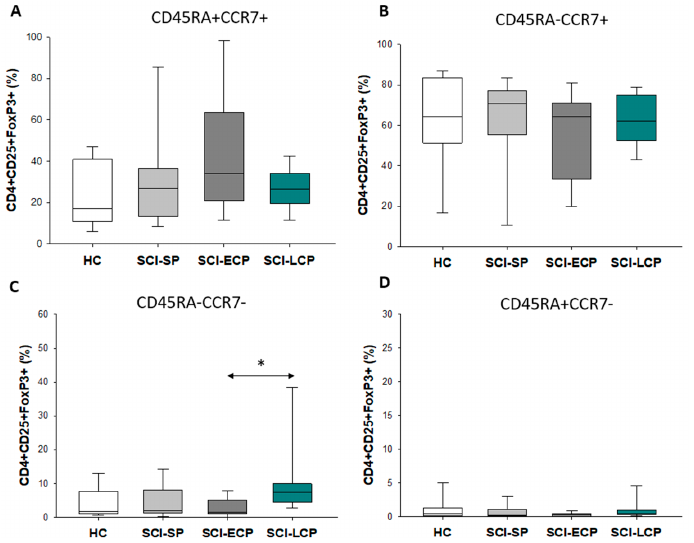
Figure 2. CD45RA and CCR7 expression in CD4+ CD25+ Foxp3+ Tregs. 4 subpopulations are recognized: ( A ) CD45RA+ CCR7+; ( B ) CD45RA − CCR7+; ( C ) CD45RA − CCR7 − ; ( D ) CD45RA+ CCR7 − . Healthy controls (HCs); chronic SCI patients with a short period of evolution (1–5 years (SCI-SP)); chronic SCI patients in the early chronic phase (5–15 years (SCI-ECP)); and chronic SCI patients in the late chronic phase (>15 years-(SCI-LCP)). p < 0.05 (*). The same results were obtained for both CD4+ CD25hi Foxp3+ (SCI-LCP = 13.5 [6.7– 12.1]; SCI-ECP = 4.7 [1.4–7.5], ** p = 0.007, Figure 3A–D) and CD4+ CD25low Foxp3 (SCI- LCP = 9.8 [3.8–9.1]; SCI-ECP = 4.2 [1.2–7.8], * p = 0.045, Figure 4A–D).